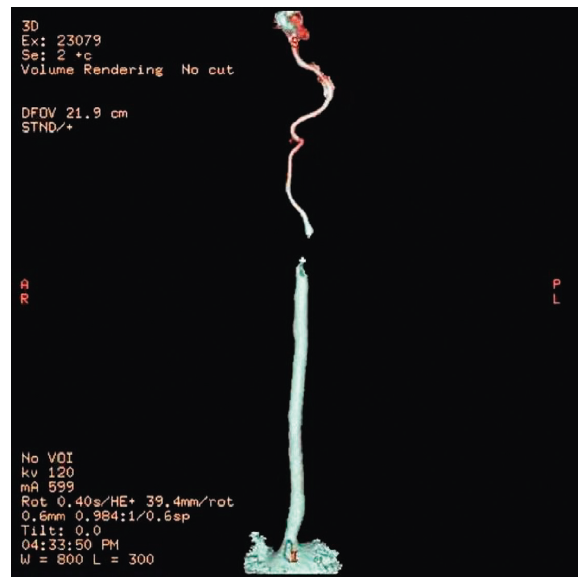
Figure 2: MDCTangiography of type II segmental ICA occlusion.